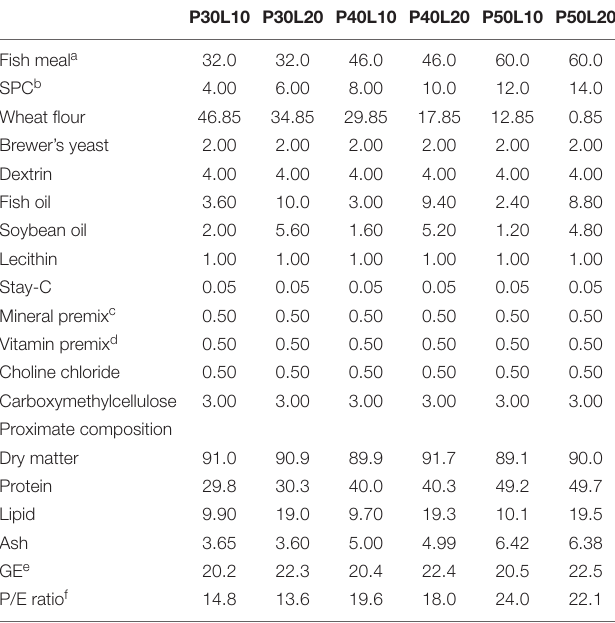
TABLE 1 | Formulation and proximate composition of the experimental diets (% dry